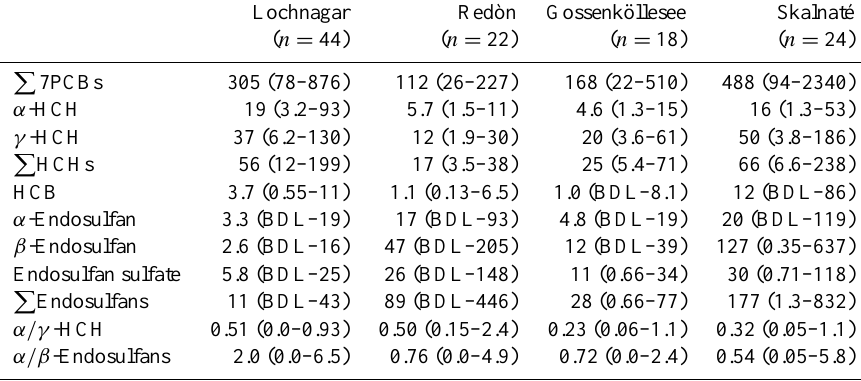
Table 2. Average atmospheric deposition fluxes of organochlorine compounds (min.–max.) in remote European regions (ngm − 2 mo − 1